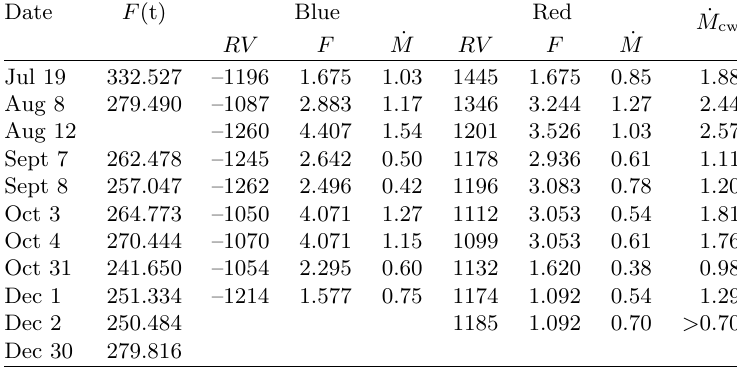
Table 1. The H (cid:11) line data. F (t) is the total H (cid:11) (cid:13)ux and _ M cw is sum of the mass-loss rates based on the satellite line components. All (cid:13)uxes are in units of 10 − 12 erg cm − 2 s − 1 , the mass-loss rates { in units of 10 − 7 ( d /1.12kpc) 3 = 2 M ⊙ yr − 1 and the radial velocities { in units of km s − 1